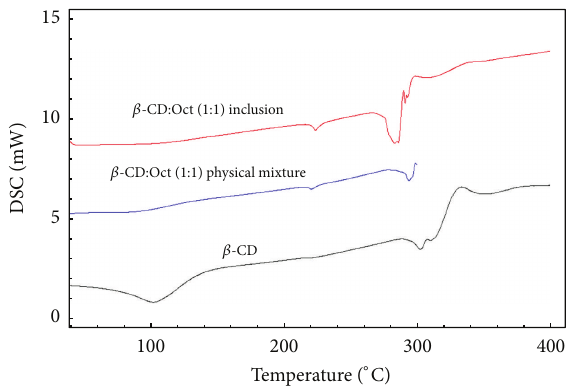
Figure 7: DSC thermograms of a 𝛽 -CD:Oct system. From top: Oct : 𝛽 -CD inclusion complex, pure 𝛽 -CD, and physical mixture of Oct and pure 𝛽 -CD.